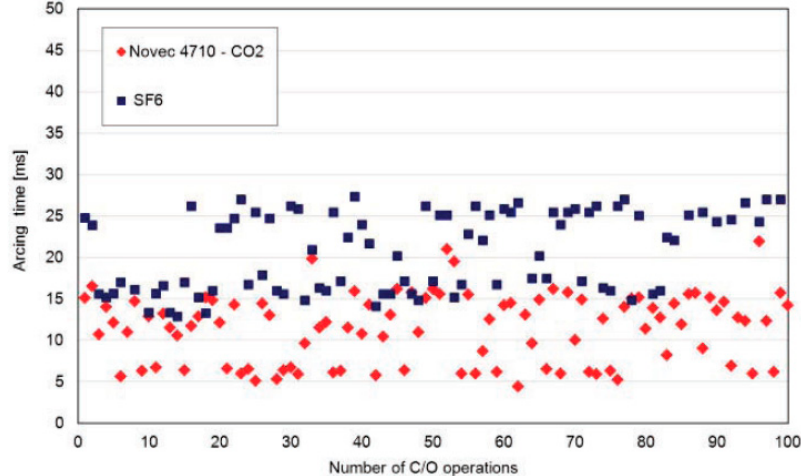
Figure 4. Arcing time of Novec TM 4710/CO 2 gas mixture and SF 6 [26].